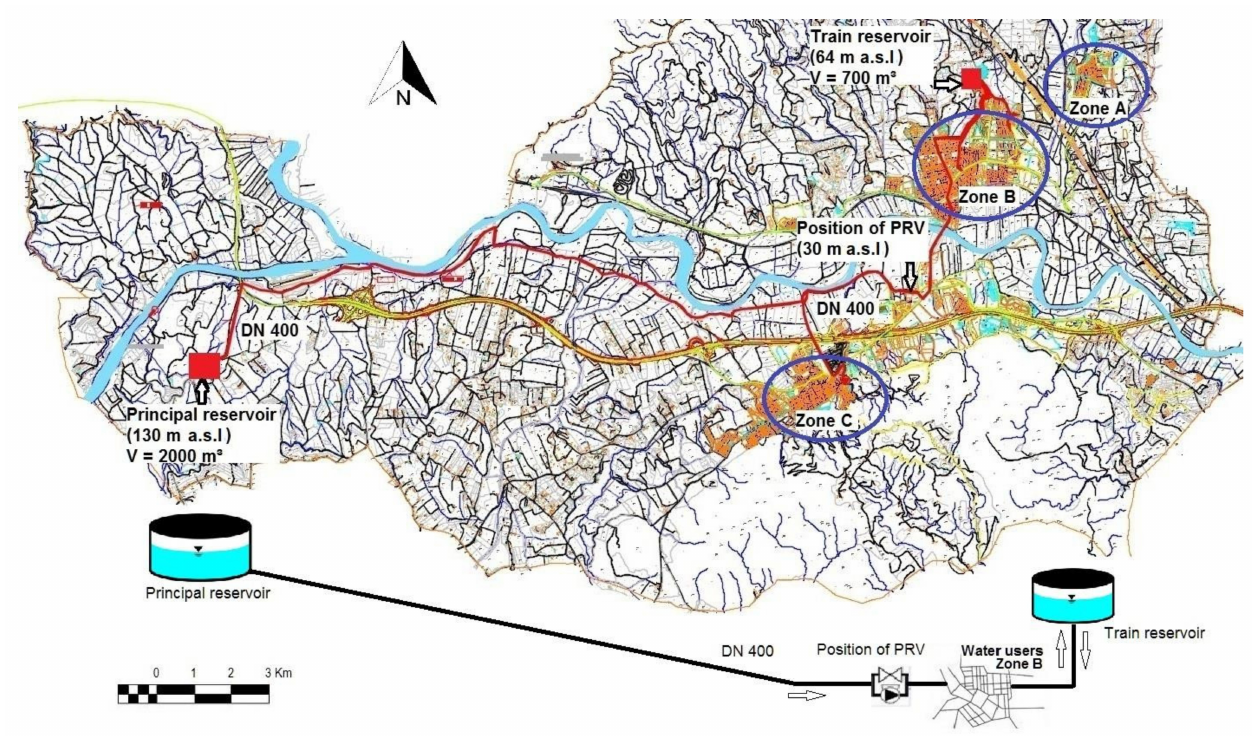
Figure 1. Geographical distribution of the drinking water network in C á rtama (Spain).